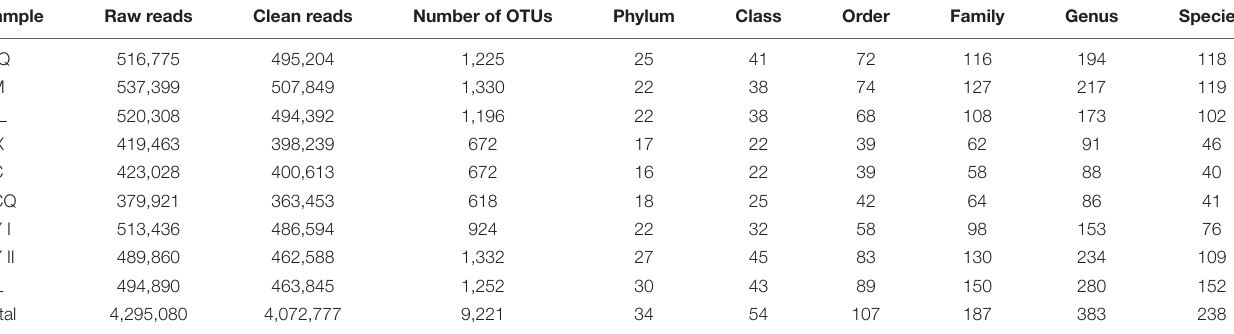
TABLE 2 | Total sequencing reads statistics in six repetitions, composition and number of microorganisms in different taxonomic levels of L. decemlineata nine samples.